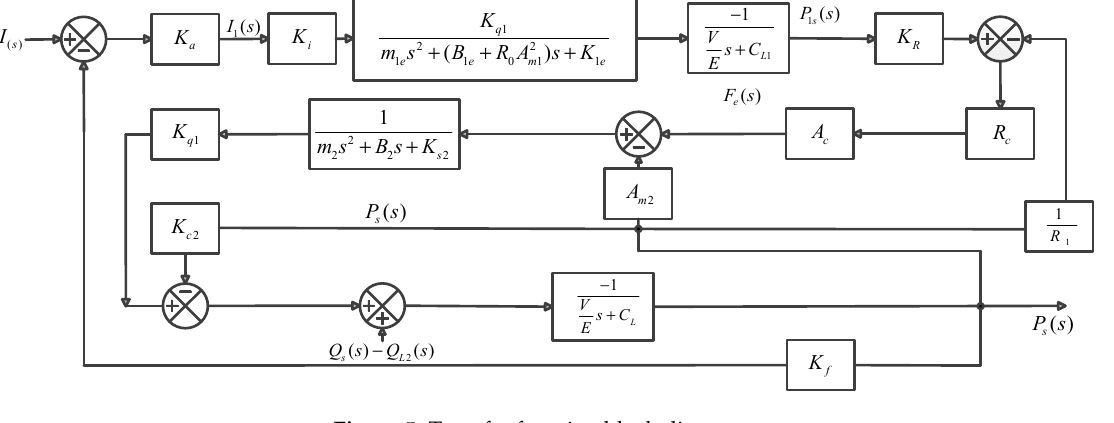
Figure 5 . Transfer function block diagram.